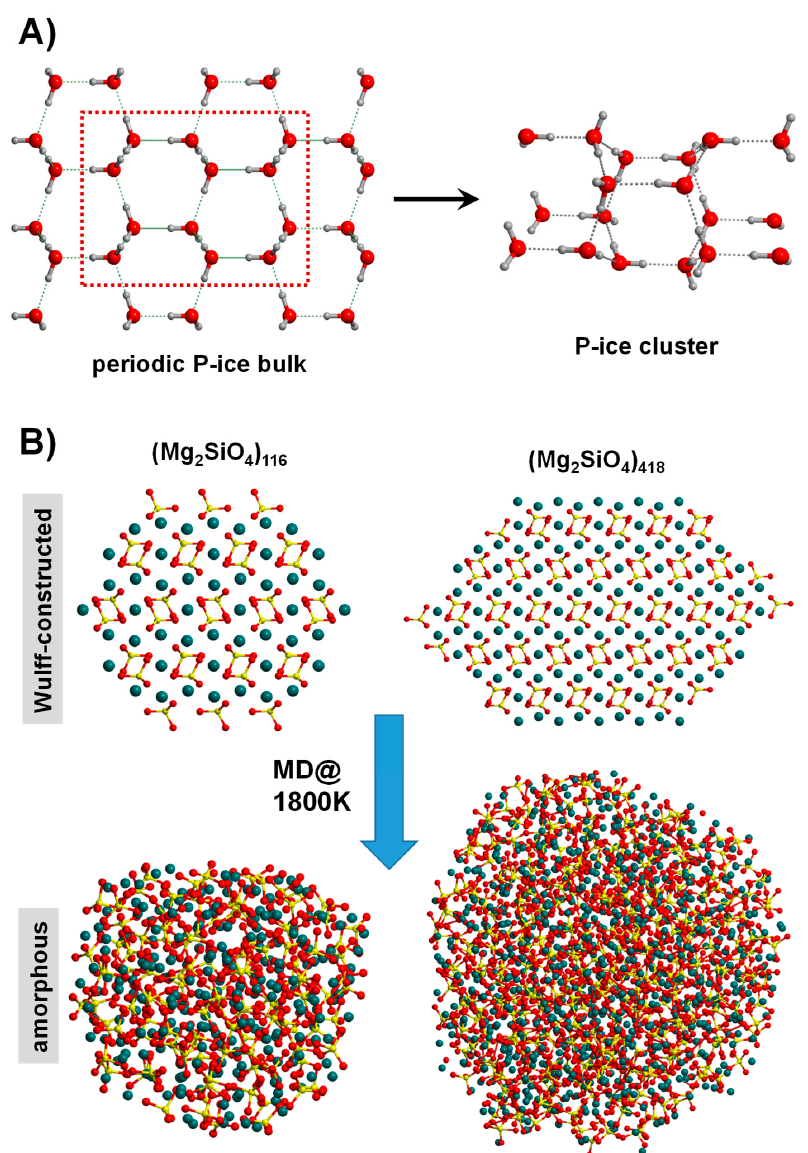
Figure 5. ( A ) Generation of a cluster model for water P-ice by adopting the top-down approach of extracting a molecular portion from the bulk system. ( B ) Nanoparticles of Mg 2 SiO 4 obtained by us- ing the Wulff-construction procedure (top structures). Running MD simulations at 1800 K leads to amorphization of the original structures (bottom